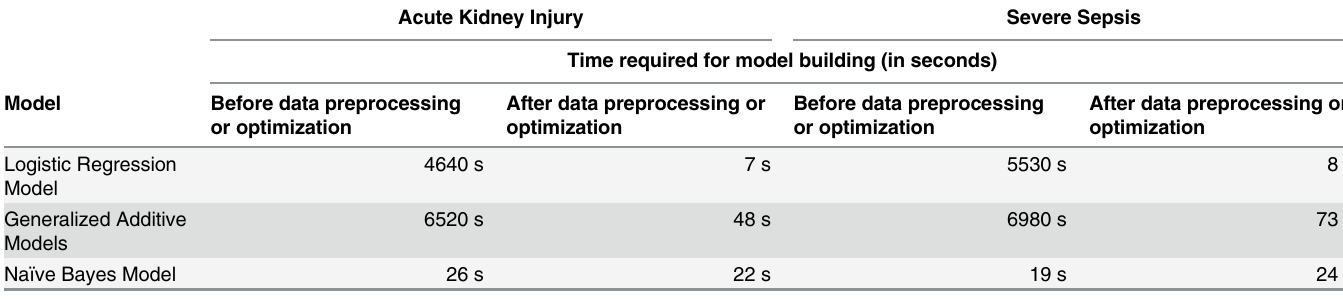
Table 3. Comparison of time required for model building in